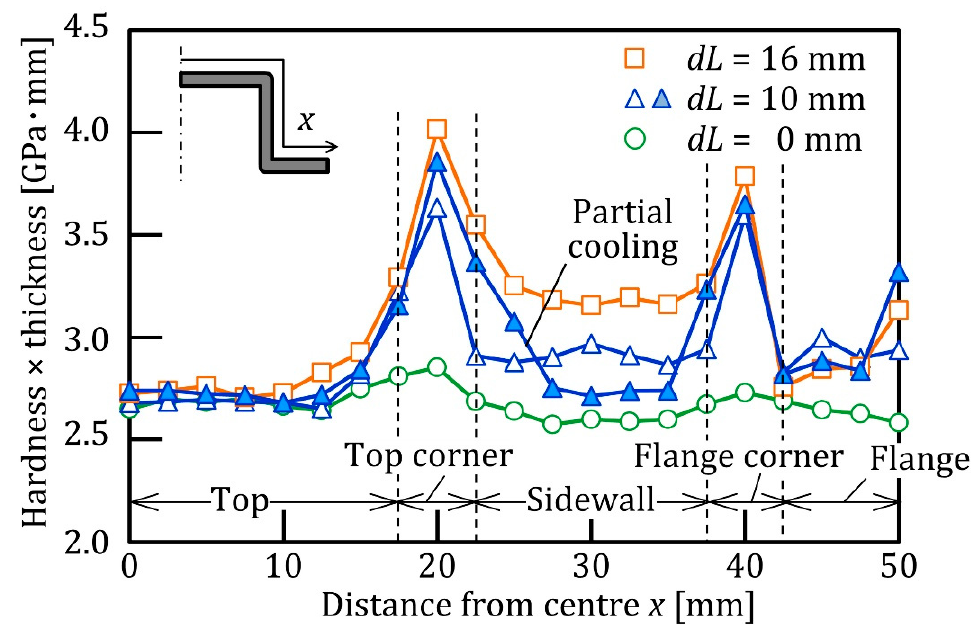
Figure 15. Distribution of strength estimated as product of hardness and thickness.